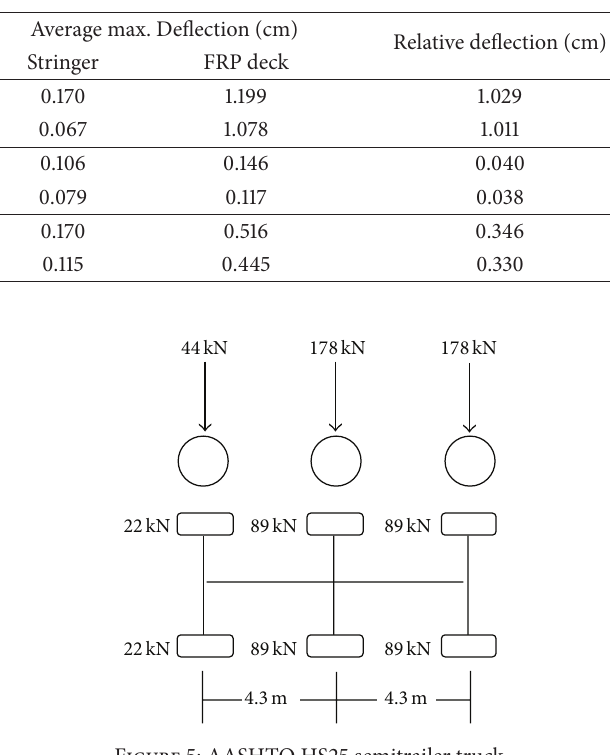
Figure 4: Link between deck and steel.